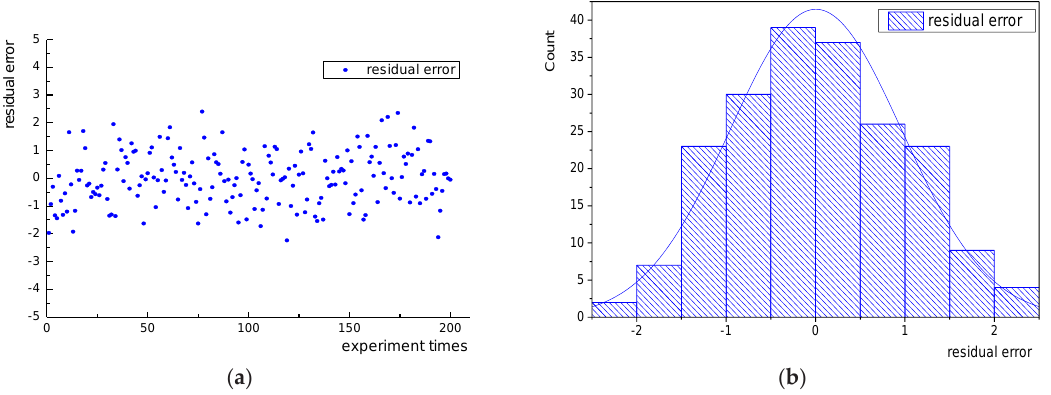
Figure 11. Residual analysis of the prediction results of the hybrid DDTree model: ( a ) the plot of residuals, ( b ) the residual